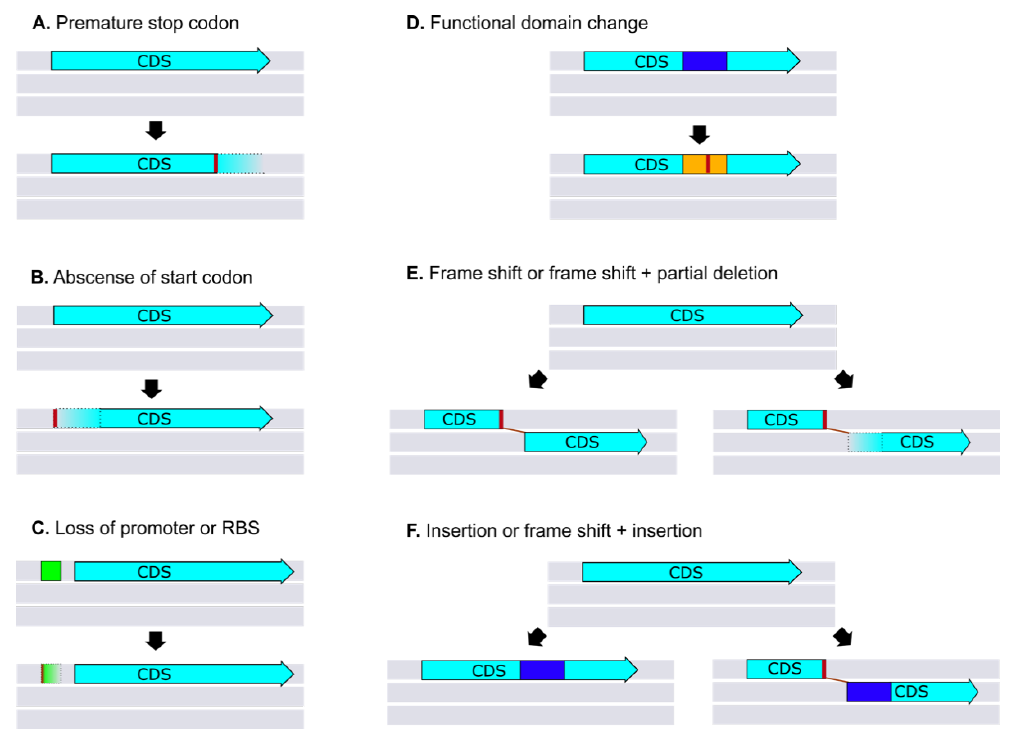
Figure 4. Pseudogenization mechanisms. Schematic representation of pseudogenes induction found in Brucella after manual curation of genome data (Table S3). ( A – C ) show pseudogenization induced